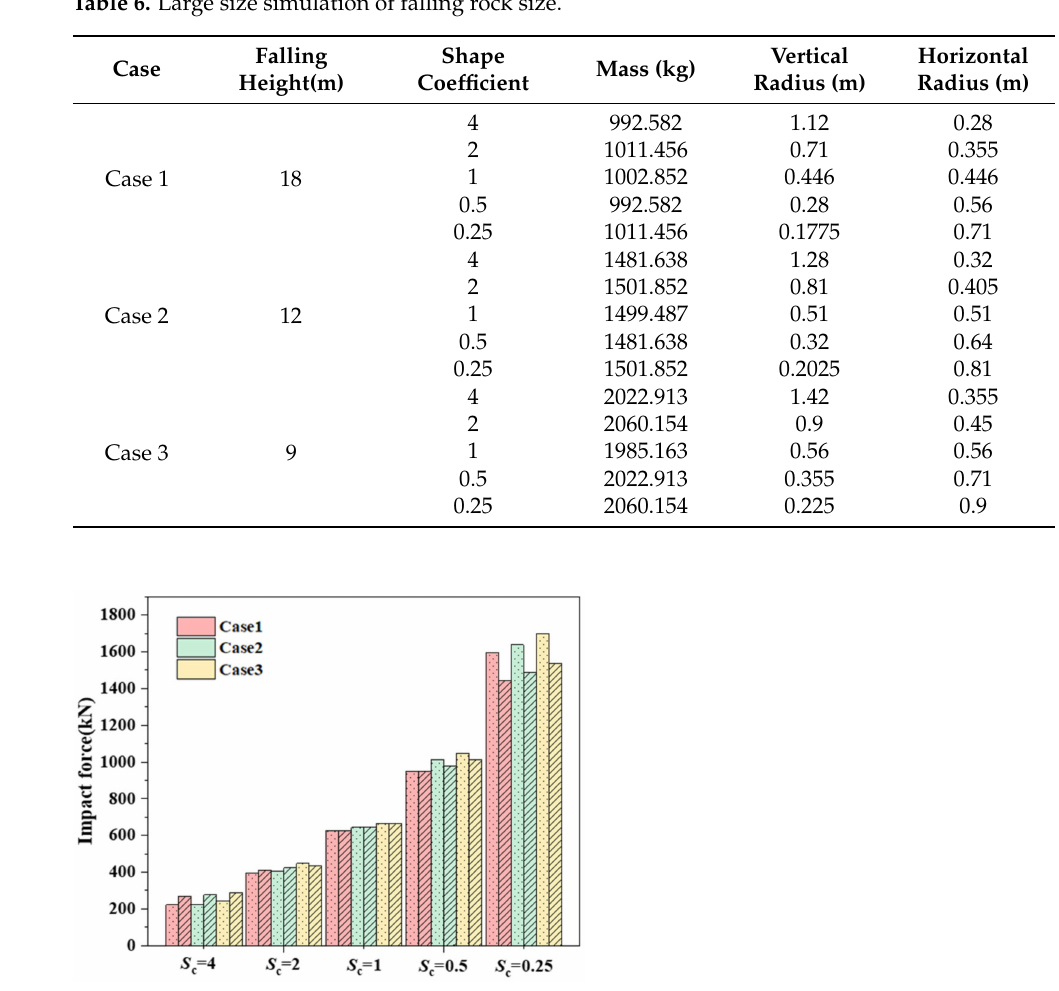
Table 6. Large size simulation of falling rock size.